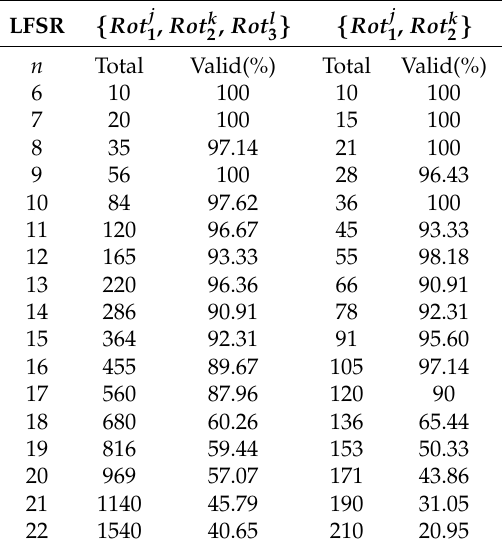
Table 3. Number of Valid Rotations at a confidence level of